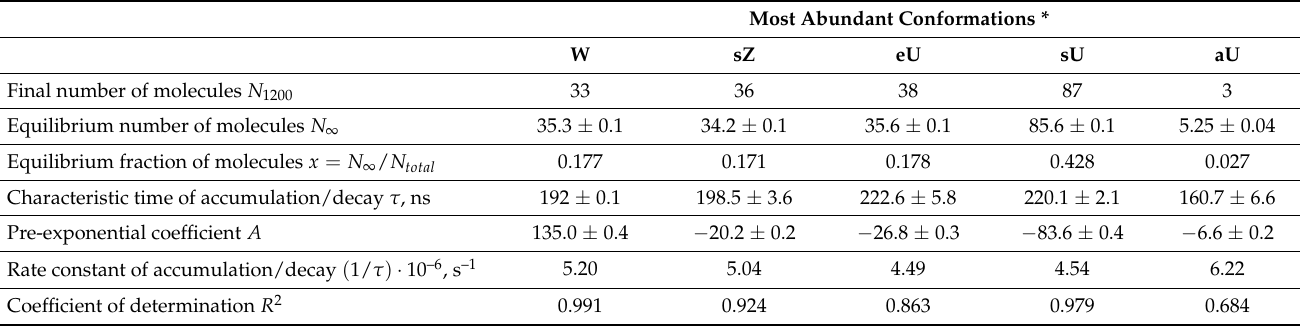
Table 1. Kinetic characteristics of the conformational transformations in the AMA-W system during 1200 ns of NPT